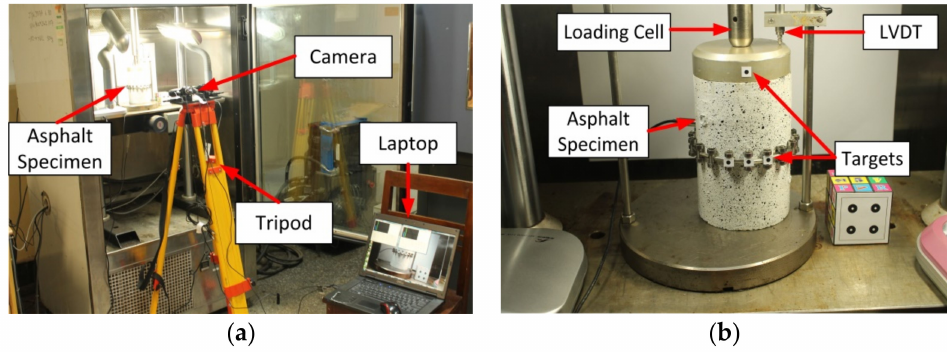
Figure 3. Test configuration: ( a ) test set up; ( b ) asphalt specimen.